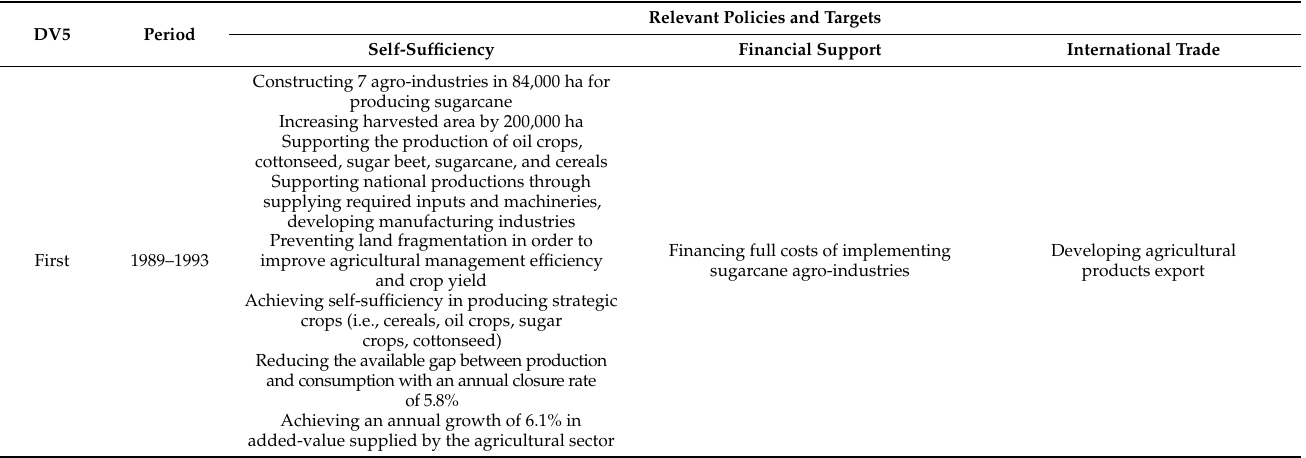
Table 2. Relevant policies/targets in first to 5th 5-year development plans (DV5) for enhancing food self-sufficiency, financially supporting agricultural development, and developing international trades